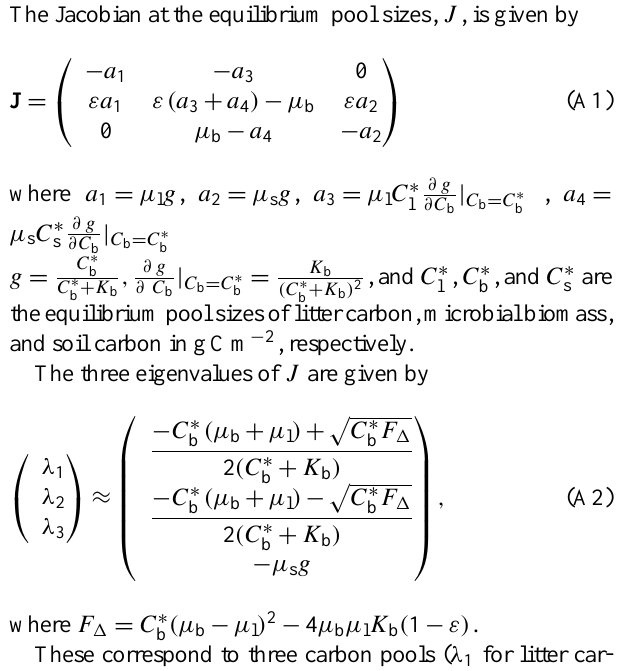
Figure A1. Half-life (a, b) and period (c, d) for model A (a, c) and B (b, d) . The unit is year for both half-life and period. Note the difference scales used for model A from model B for both half-time and period. The purple region represents non-oscillatory region for model A in (c) , and a period greater than 30 years for model B in (d) . We assumed that a = 0 for all